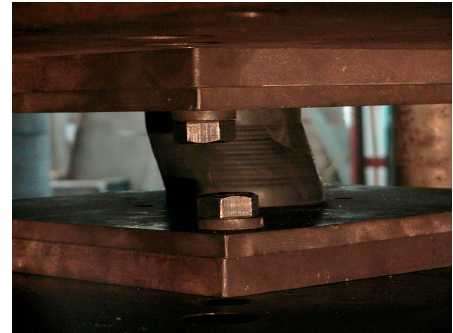
Figure 3. The rubber bearing in testing.